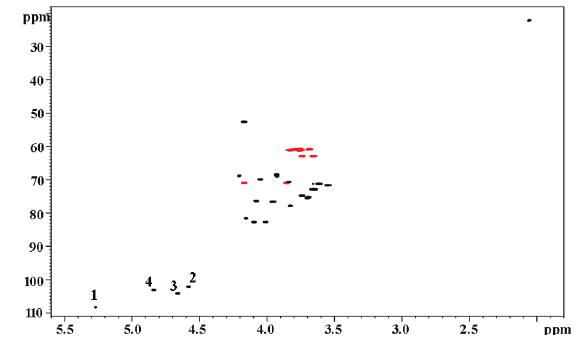
Figure 5 - 1 H- 13 C HSQC spectrum of the tetrasaccharide alditol from epimatigotes of T. cruzi strain Silvio X10/1 (CH black, CH red). 1. Gal f -β-1-4-GlcNAc-ol; 2. Gal p -β-1-6- 2 GlcNAc-ol; 3. Gal p -β-1-2-Gal p ; 4 Gal p -β-1-3-Gal p .